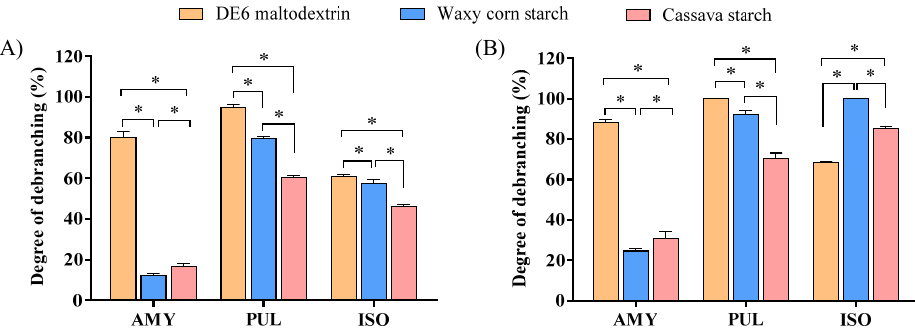
Figure 5. Debranching degree of dextrin and starch by AMY, PULand ISO under different treatment times. ( A ) debranched for 6 h; ( B ) debranched for 24 h. Means with the asterisk within the same group are significantly different ( p < 0.05).